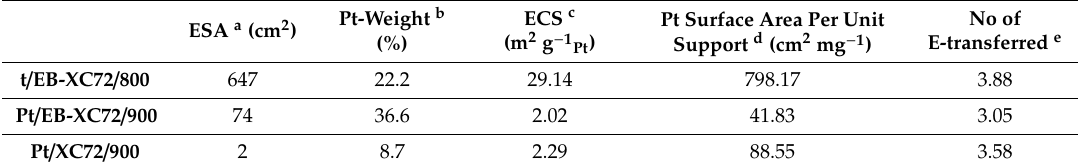
Table 4. Particle size and electrochemical properties of